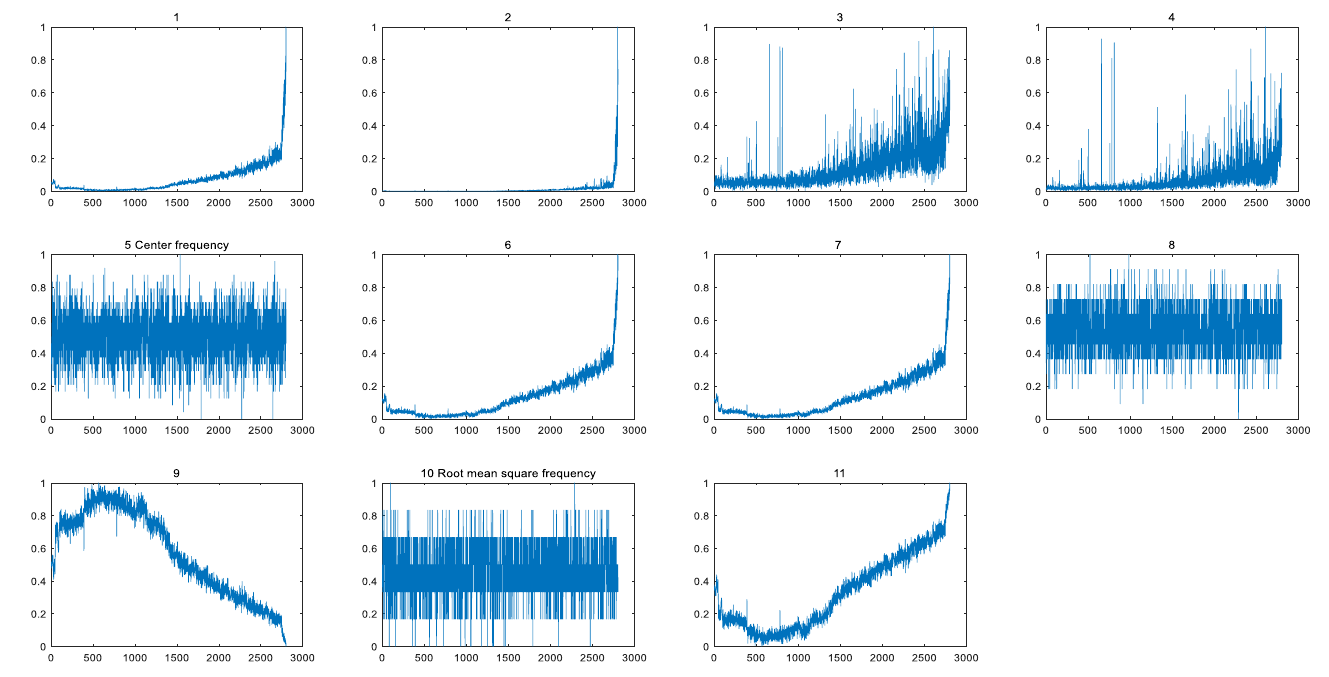
Figure 9. Envelope kurtosis values of each component and original signal.